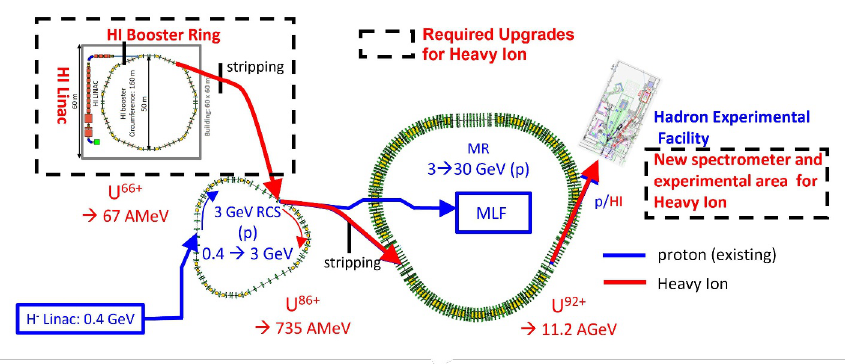
Figure 2. Schematic view of the J-PARC accelerator setup and required upgrades for the heavy ion